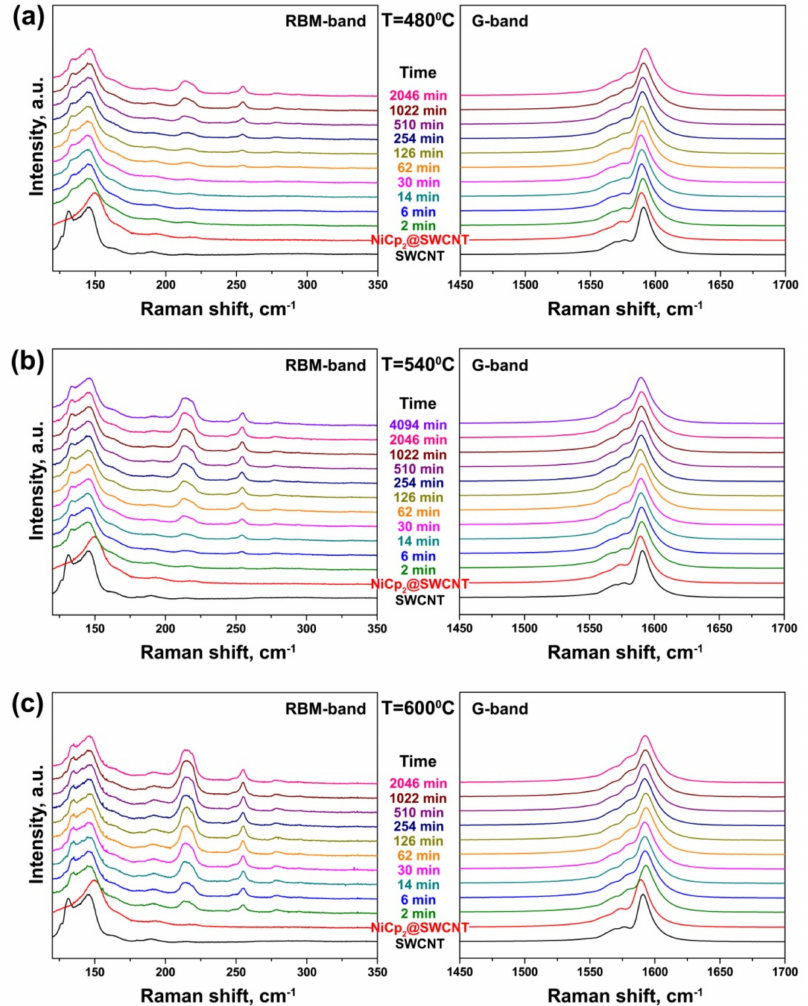
Figure 6. The evolution of the RBM- and G-bands of the Raman spectra of the nickelocene-filled SWCNTs upon their in situ annealing at temperatures of 480 ◦ C ( a ), 540 ◦ C ( b ) and 600 ◦ C ( c ) for 2–4094 min. The Raman spectra are acquired at a laser wavelength of 633 nm (E ex = 1.96